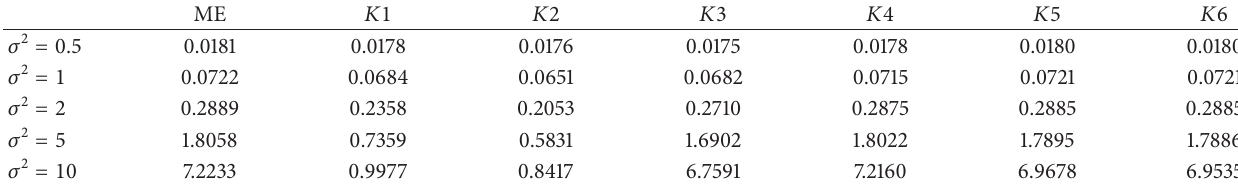
Table 13: Estimated MSE with 𝑛 = 50 , 𝑝 = 6 , and 𝛾 = 0.75 .